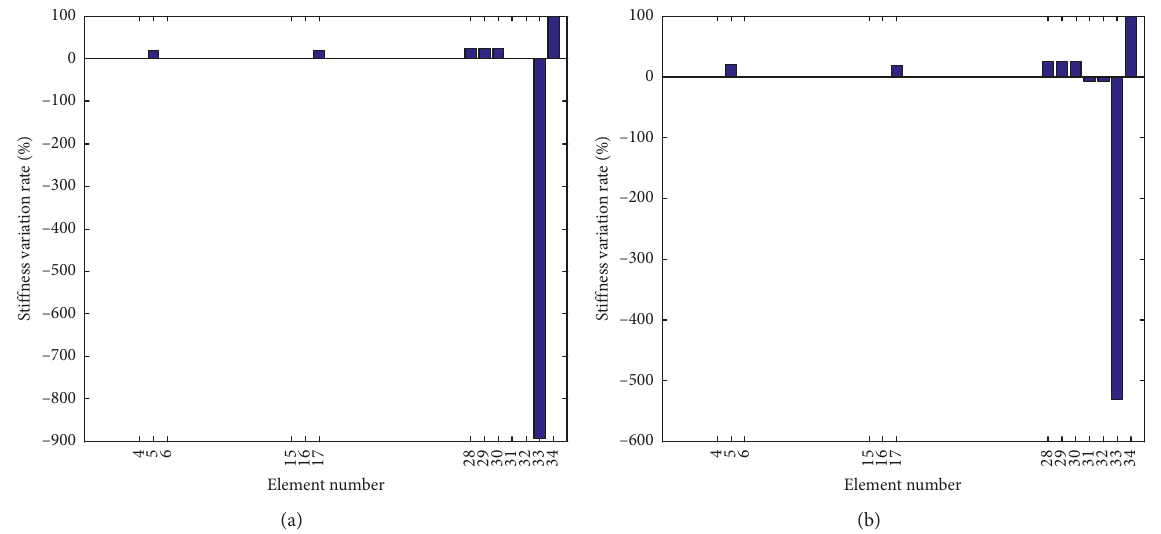
Figure 13: Damage detection by the substructuring method: (a) noise-free measurement data; (b) measurement data contaminated by 5% noise.